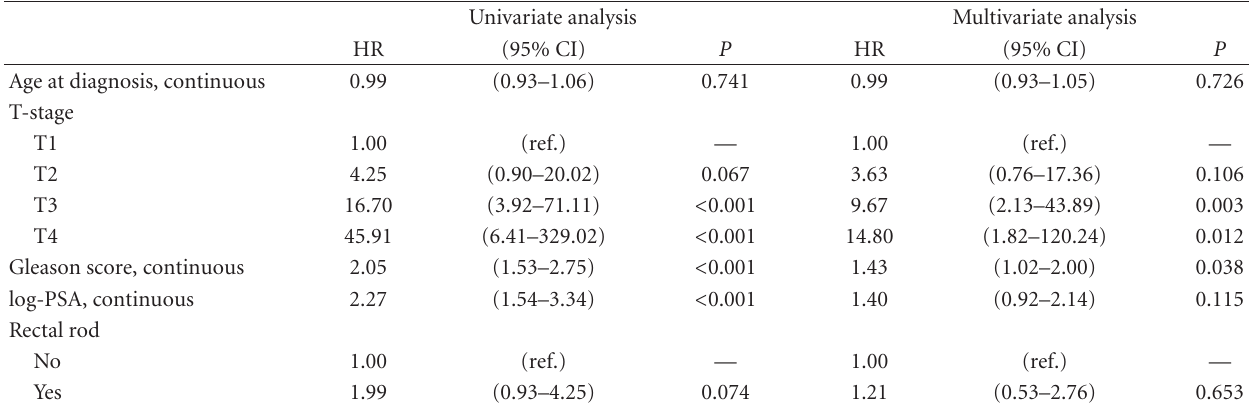
Table 2: Cox regression model—PSA relapse.